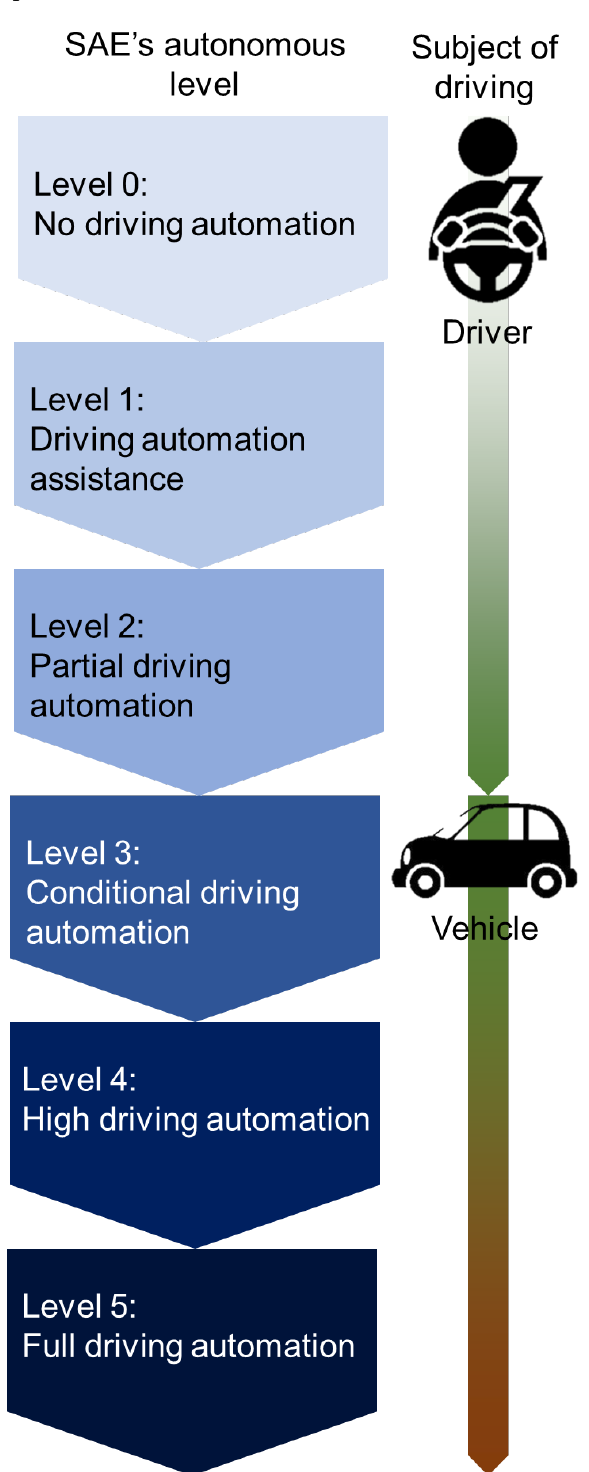
Figure 1. SAE’s autonomous driving level and subject of driving at each level.